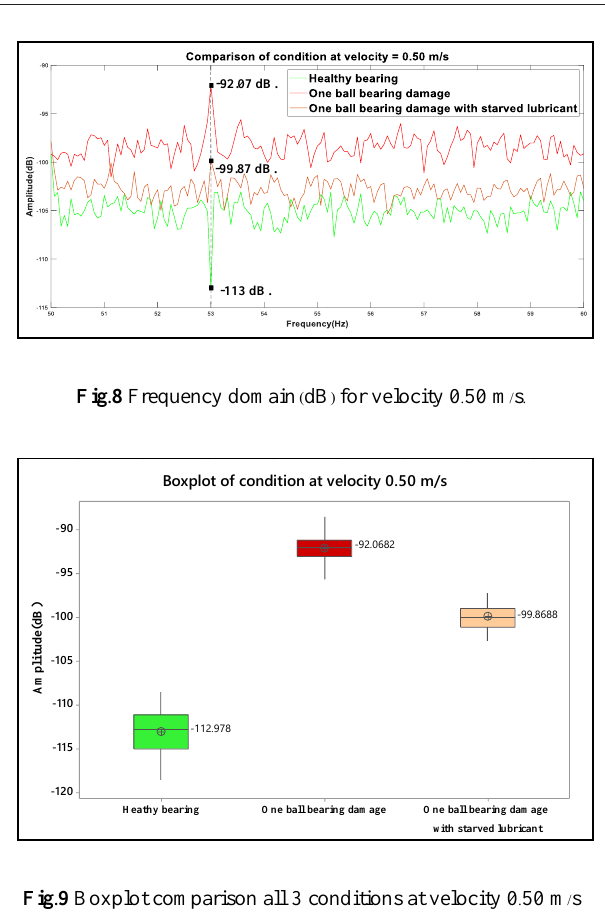
Fig . 9 Boxplot comparison all 3 conditions at velocity 0 . 50 m / s Table 2 . Amplitude ( dB ) at velocity 0 . 50 m / s Condition